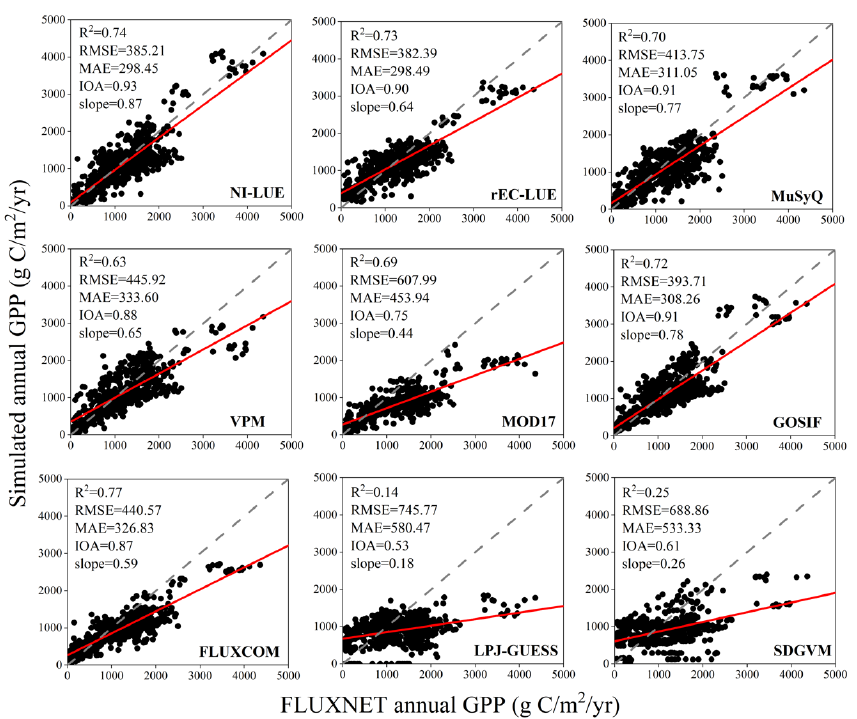
Figure 12. Comparisons between FLUXNET GPP and various GPP products at yearly time scales. Dashed lines are 1:1 lines. Red solid lines are linearly fitted lines. Figure 13(a) showed the inter-annual variations in the annual total GPP of different products. There were great differences in the global annual total GPP of different products, ranging from 104.48 Pg C to 137.28 Pg C. Among all products, the global annual total GPP of the five LUE models ranged from 108.79 Pg C to 129.70 Pg C. The annual total GPP simulations of two process-based biophysical models in TRENDY differed considerably, with LPJ-GUESS GPP of 106.62 Pg C and SDGVM GPP of 133.65 Pg C. However, these two products had similar trends, and they can reflect the fluctuations around 2009 as well as the NI-LUE GPP produced in this study. For data-driven GPP products, the global an- nual total GPP of GOSIF GPP was the highest (137.28 Pg C), while that of FLUXCOM GPP was the lowest (104.48 Pg C). The global annual total NI-LUE GPP ranged from 125.09 Pg C to 133.75 Pg C from 2001 to 2018, placing at the middle of the various GPP products, which is in a reasonable range based on statistics for other products. Figure 13 (b) showed the correlation coefficient matrix of the interannual variations of different products. The study showed that the interannual variation of NI-LUE GPP was significantly positively correlated with GOSIF GPP, FLUXCOM GPP, VPM GPP, LPJ-GUESS GPP, and SDGVM GPP, and the correlation coefficients with MOD17 GPP and MuSyQ GPP were only 0.36 and 0.33, respectively. However, since rEC-LUE GPP showed a decreasing trend from 2001 to 2018, it was negatively correlated with most of the GPP products.